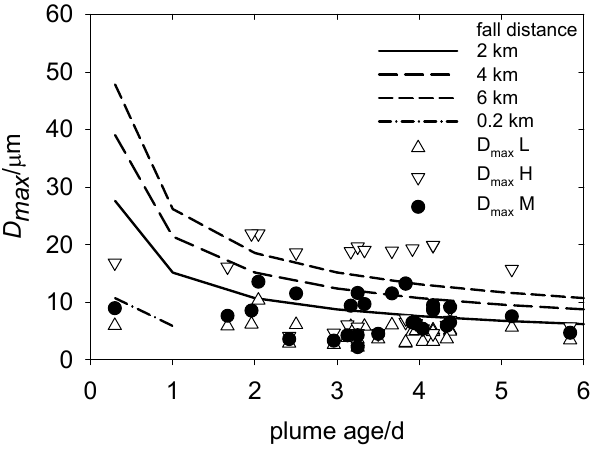
Fig. 22. Comparison of aircraft and ground-based derived ash- mass concentration versus altitude. The results are obtained over Leipzig (15:08–15:15UTC 19 April 2010: dots representing 300- m-smoothed results) and Munich (17:34–17:45UTC same day: ev- ery tenth data point after 80-m-smoothing). The grey shaded areas represent the range of uncertainties of these results. Also shown are the leg-mean mass concentration values derived from the Falcon in- situ data for cases L, M and H, with vertical error bars indicating the layer depth in which these data were taken (leg 1 and leg 3, Table